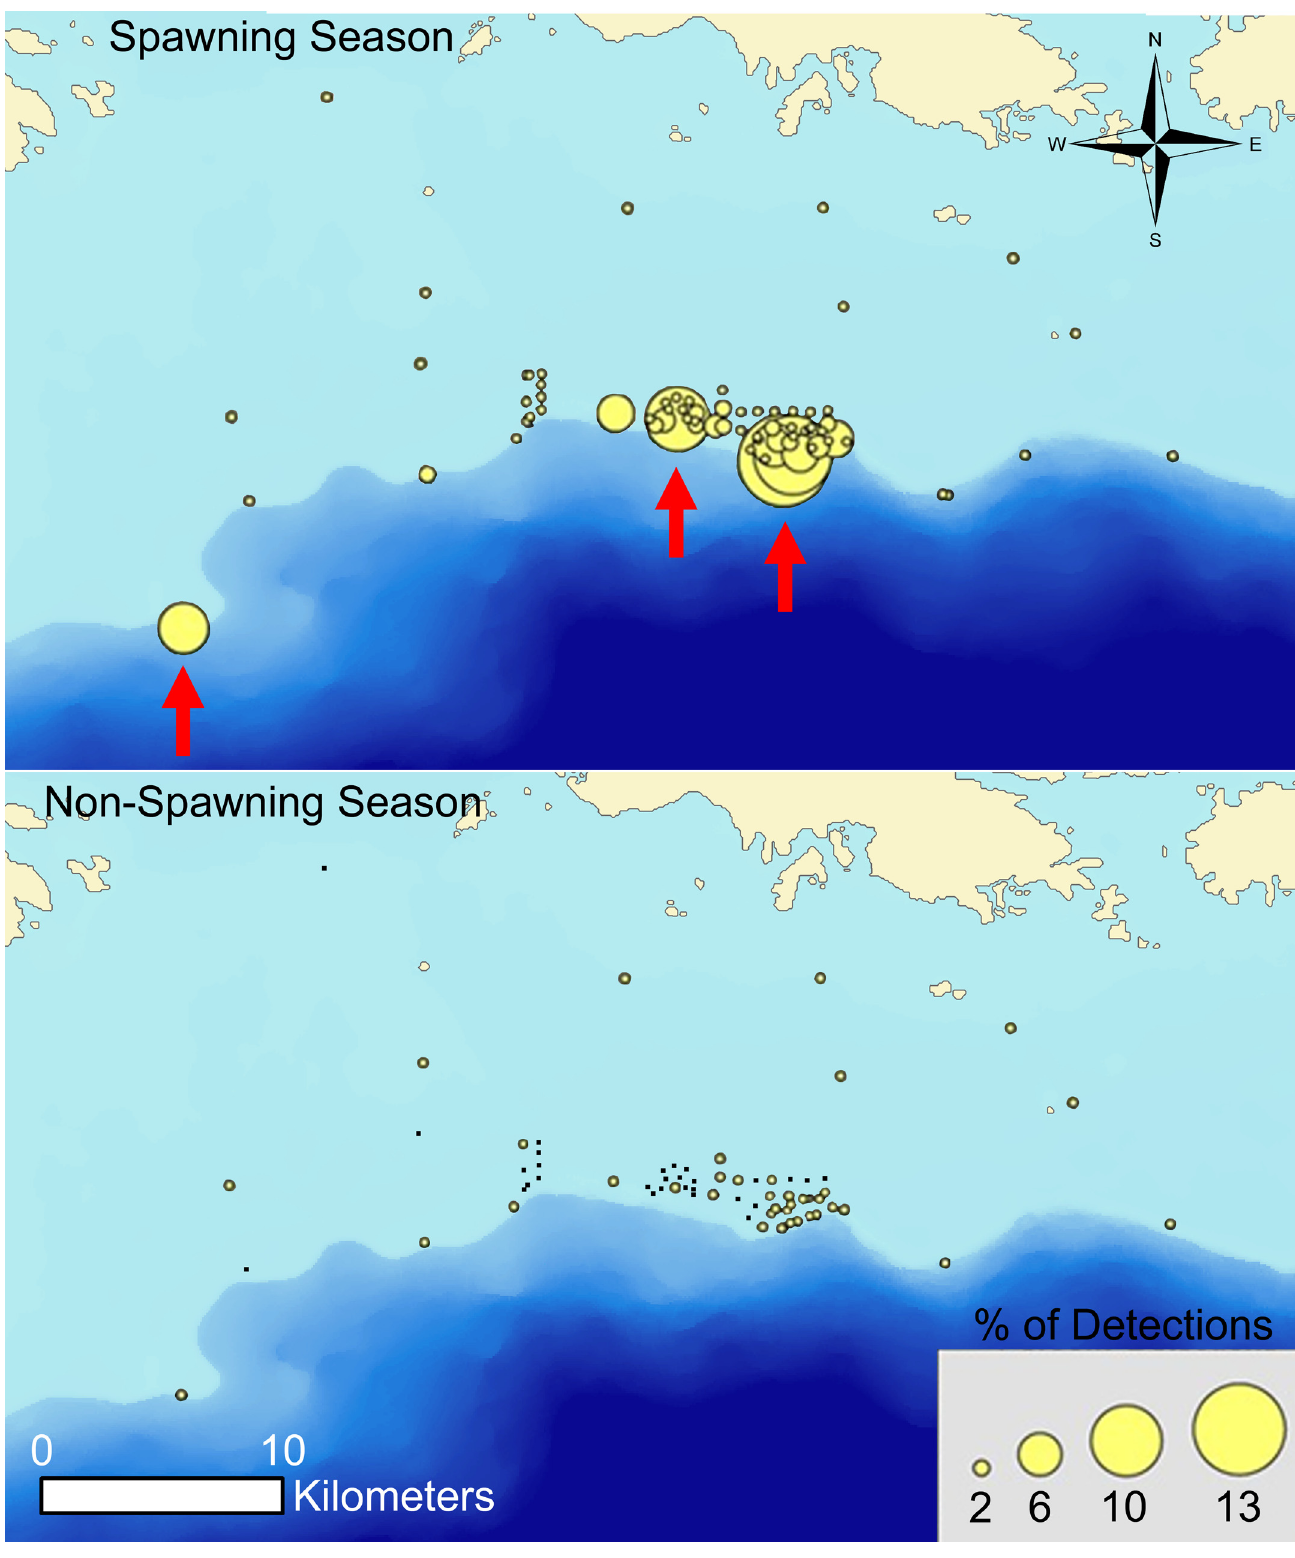
Fig 7. Detections on receivers as proportion of total detections on all receivers for lemon sharks during grouper spawning season and non- spawning season 2007 – 2011. Red arrows represent Grammanik Bank, Hind Bank MCD and El Seco spawning sites (right to left). doi:10.1371/journal.pone.0151221.g007 PLOS ONE | DOI:10.1371/journal.pone.0151221 May 4,